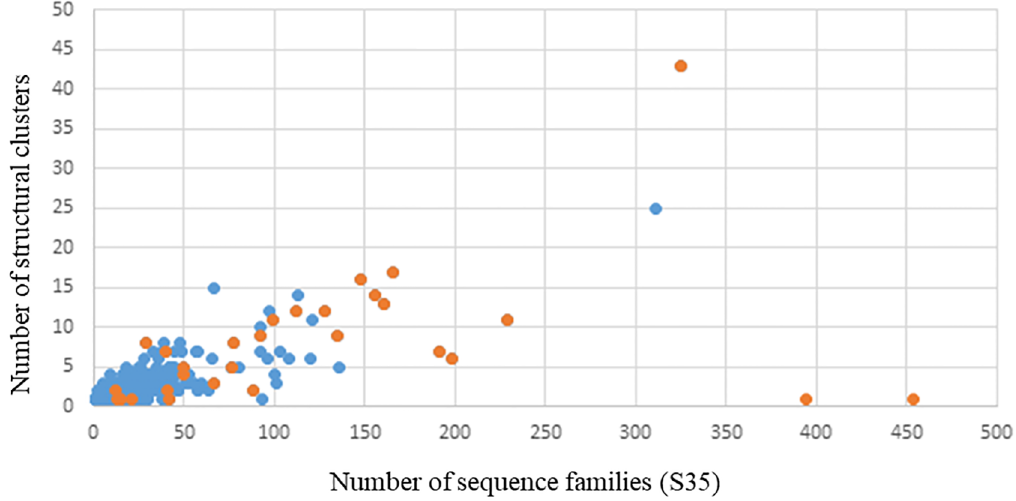
Fig 5. Number of different structural and sequential clusters derived from CATH database. Blue dots represent proteins with less than 5 BPs and the orange ones those with 5 or more BPs. It is possible to see that proteins with more than 5 BPs are more diverse structurally and